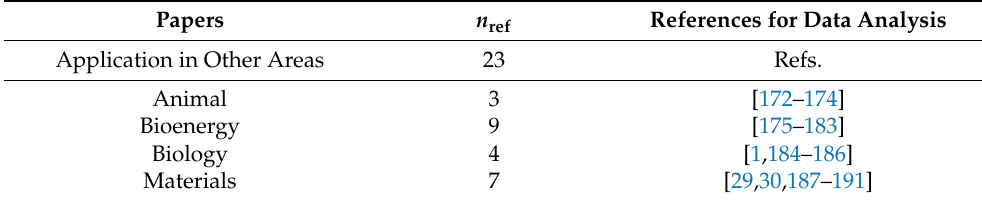
Table 5. Application of mixture design in other